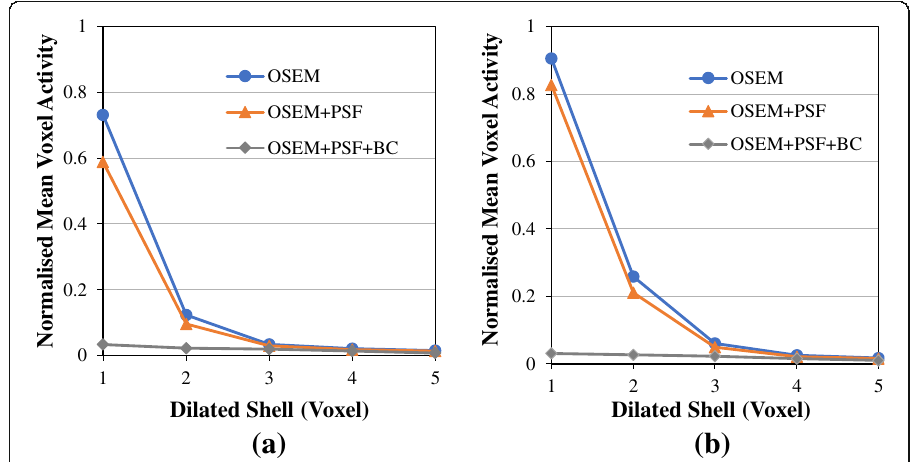
Fig. 11 The normalised mean activities within the dilated shells surrounding the NEMA bottle obtained at three full iterations with a no post-filter and b 4-mm Gaussian post-filter. This demonstrates how spill-in activity from the hot bottle to the surrounding shells reduces as we move farther away from the bottle. The voxel activities were normalised with the actual activity in the